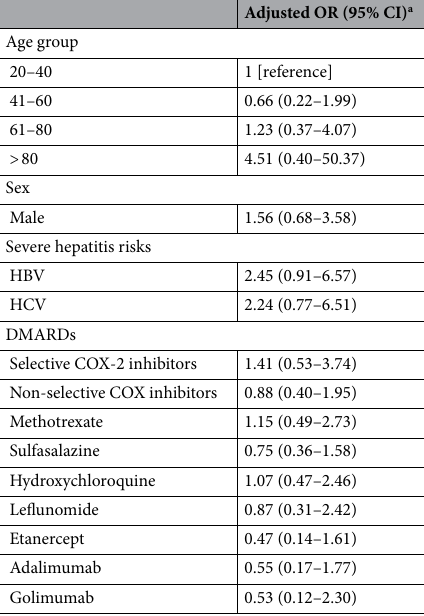
Table 3. Evaluation of Potential Risk factors of Severe Hepatitis Adverse Events Related to Isoniazid Treatment (n = 722). a Odds ratios (OR) were adjusted for all variables included in multivariate logistic regression model as shown in the table.